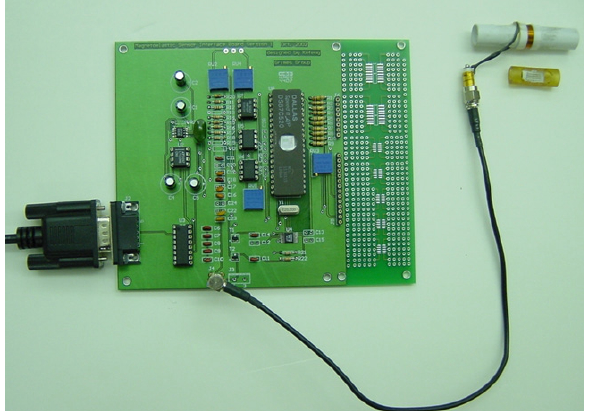
Figure 3d . The magnetoelastic sensor electronics module. The sensor interrogation and detection solenoid (upper right) is connected to the board via a coaxial cable. The magnetoelastic microsensor array (shown in greater detail in Fig. 11 ) is mounted on a plastic holder (brown plastic tube section on the top right) that slips inside the